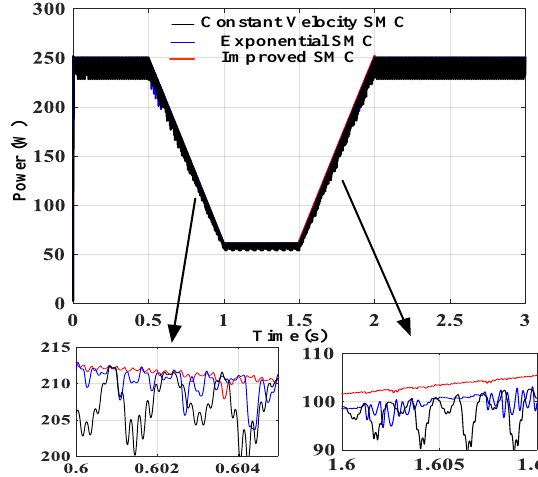
Figure 16. MPPT curve under ramp G , T .